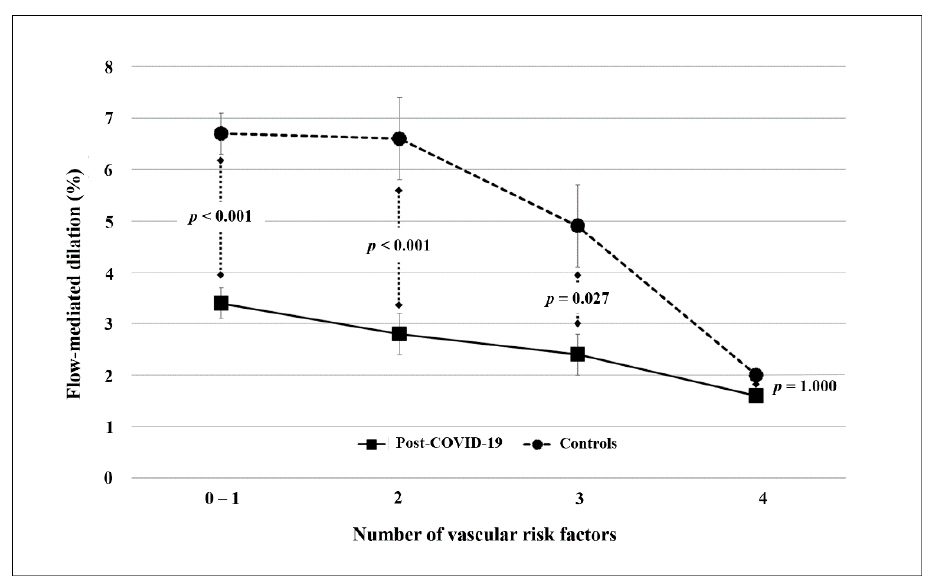
Figure 2. Difference in flow-mediated dilation (FMD) between convalescent coronavirus disease 2019 (COVID-19) patients and controls stratified according to the number of vascular risk factors. Among convalescent COVID-19 patients, FMD values showed a significant correlation with PaO 2 (rho = 0.247, p = 0.004), FEV 1 % (rho = 0.436, p < 0.001), FVC% (rho = 0.406, p < 0.001), and DLCO% (rho = 0.280, p = 0.008) (Figure 3).